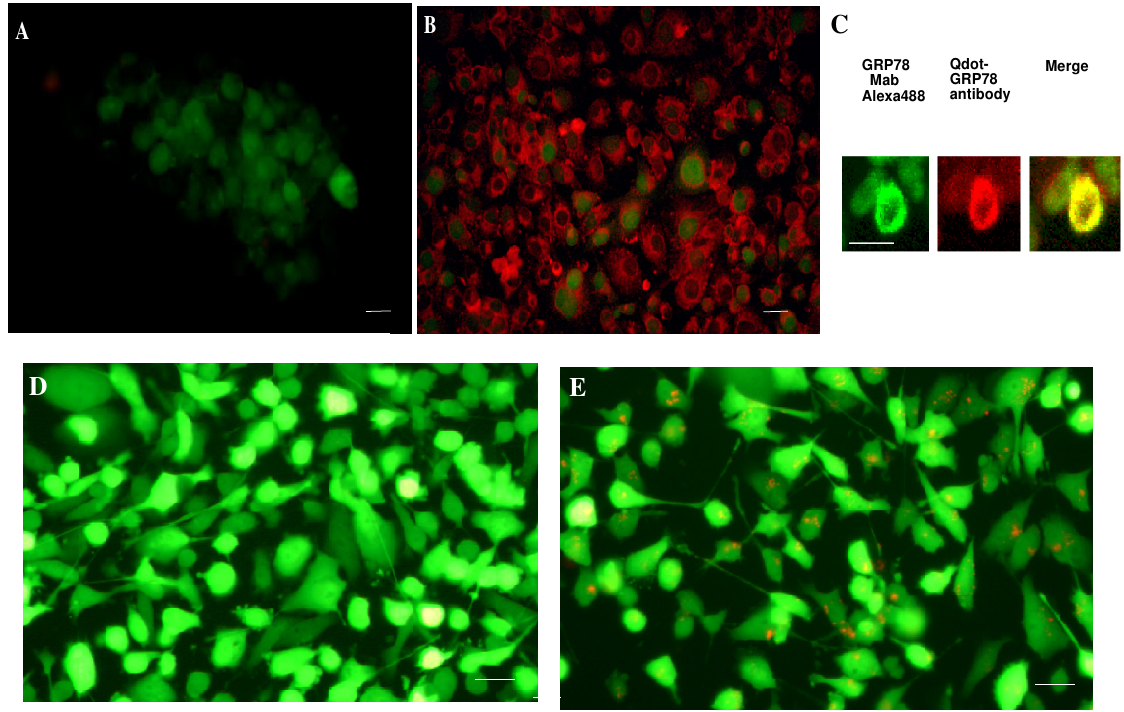
Figure 2. Immunohistochemistry of Qdot-GRP78 antibody in MDA-MB-231/GFP breast cells and LNCaP prostate cancer cells. ( A ) and ( B ) Fluorescence images of cells staining with Qdot625-GRP78 antibody. ( A ) control cells staining with unlabeled nanobeads; ( B ) MDA-MB-231/GFP cells staining with Qdot-GRP78 antibody; ( C ) Scanned confocal microscopy imaging in LNCaP prostate cancer cell, stained with anti-GRP78 mouse monoclonal antibody with secondary Goat anti-mouse IgG labeled with Alexa488(green)and Qdot- GRP78(red dots) and overlapped with two probes (yellow); ( D ) and ( E ) Internalization of Qdot-GRP78 antibody by MDA-MB-231/GFP cells. Cells were incubated with unlabelled nanobeads. ( D ) or Qdot-GRP78 antibody; ( E ) at 37 °C for 16 h. Cells were then washed with PBS and analyzed by fluorescence microscopy; ( F ) Scanned confocal microscopy imaging in MDA-MB-231/GFP cell (green), treated with control unlabelled beads; ( G ) Qdot- GRP78(red dots) was detected inside MDA-MB-231/GFP cell; ( H ) 3D reconstruction of confocal Z stack with 0.8- µ M, GFP cell showing in green channel, while Qdot-GRP78 showing in red channel. Scale bar represents 20 µ m; ( I ) Western blot analysis of GRP78 protein in Qdot-GRP78 antibody treated cells. Cells either treated with control (unlabelled Qdot) or Qdot-labeled antibody. Phosphorylated Akt-ser473 protein was detected by an anti-anti-Akt-se473 antibody and Pan-Akt antibody was used as a loading control. The western blot represents three independent experiments. ( J ) MDA-MB-231/GFP cells were incubated with various concentrations of Qot-GRP78 antibody for 24h. Apoptotic nuclei or nuclear DNA strand breaks were visualized using Hoechst DNA dye H33342 (10). A minimum of 200 cells were counted in each sample and condensed or fragmented nuclei were expressed as a percentage of the total number of nuclei. Values are presented as mean ± S.D. of three determinations. * indicates significant difference ( p < 0.05) between none treatment cells and antibody treatment cells. C A B Qdot- GRP78 GRP78 Mab antibody Alexa488